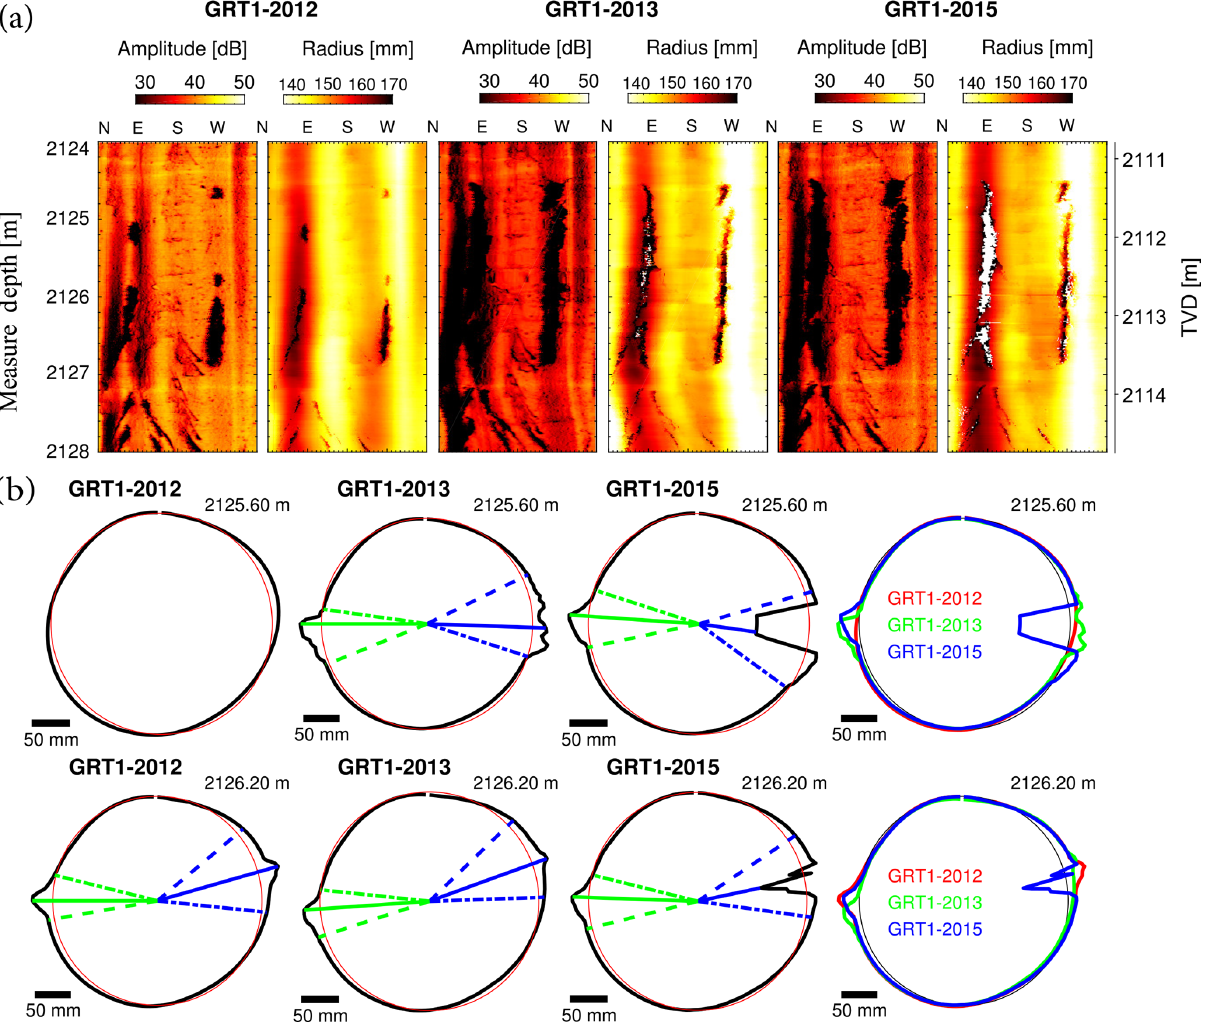
Figure 7. Examples of breakout shape evolution between the three successive images collected in GRT-1 in sandstones. (a) The amplitude images and the radius computed from the time transit images for a section of GRT-1 from 2124 to 2128m (MD) in 2012, 2013 and 2015. (b) The mean section computed at 2125.6 and 2126.2m (MD) from the time transit images averaged over 60cm intervals. The sections are represented along with an 8.5inch radius circle representing the unaltered open-hole section. The sections from the images of 2012, 2013 and 2015 are superposed on the far right of panel (b)